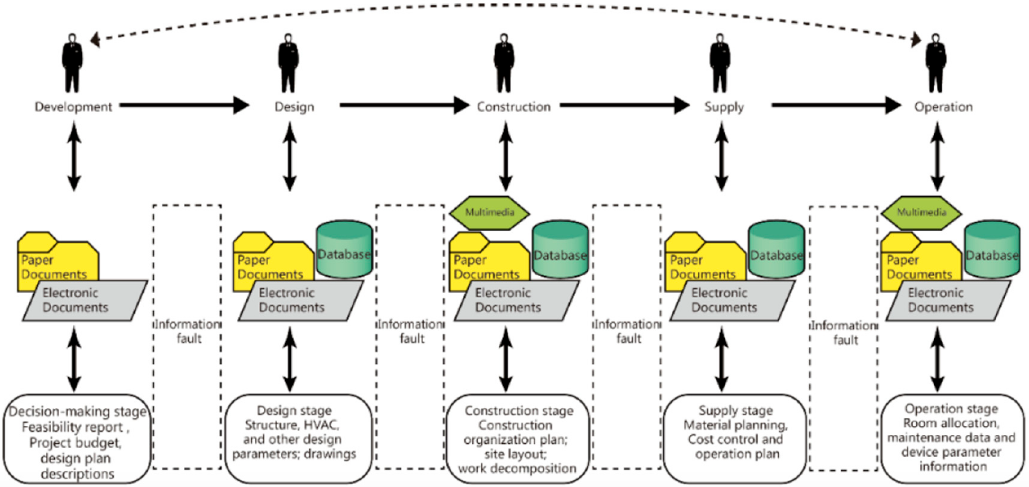
Figure 4. Traditional building information value chain model (Hui et al. [35]; reprinted with permission: IOP PUBLISHING, LTD).